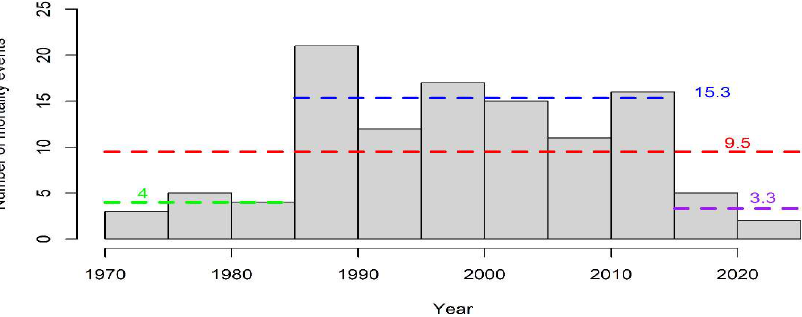
Figure 5. The frequency distribution of modern mortality events over time. Dashed red, blue, green and purple lines show the average number of mortality events over the entire period (1964–2021; the only 1964 record was excluded from the analysis due to lack of information), over the periods 1985–2015, 1970–1985 and 2015–2021, respectively.